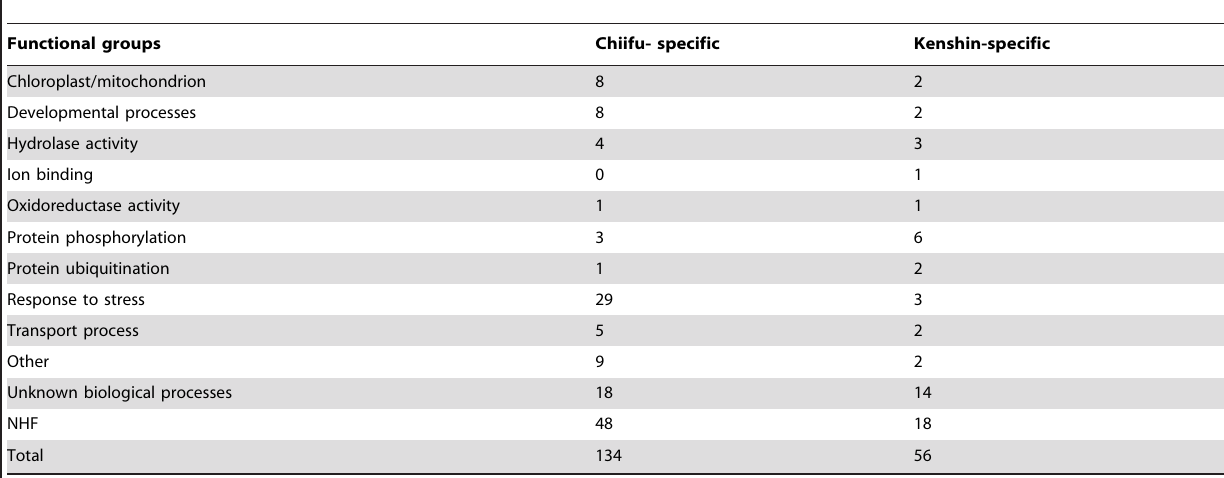
Table 2. Functional categorization of genotype-specific expressed genes.